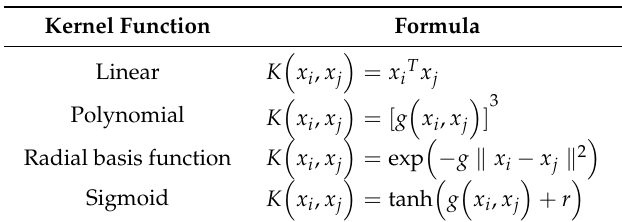
Table 3. A list of kernel functions.